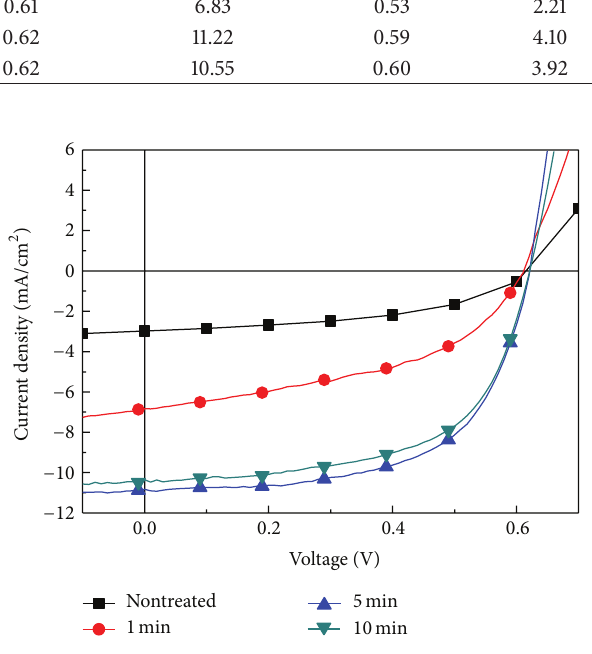
Figure 2: 𝐽 - 𝑉 characteristics of organic photovoltaic devices with thermal/laser coannealing process under different